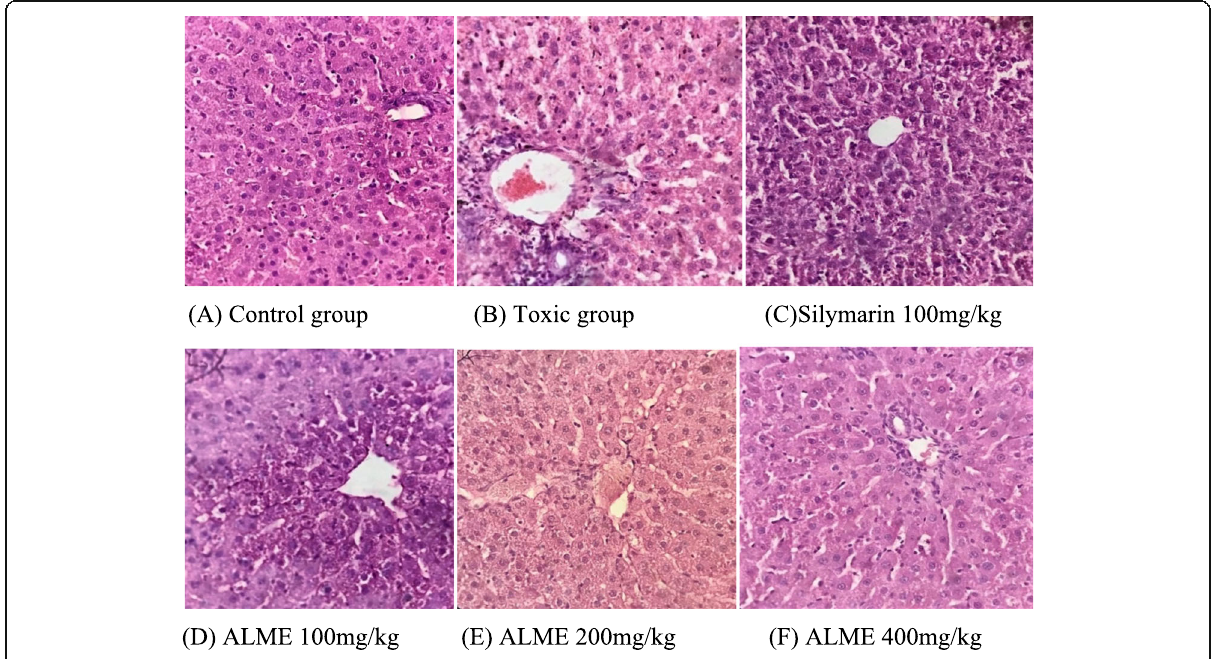
Fig. 1 Histopathological changes in hepatic tissue of rats. Done by Digital Motic Microscope Magnification 100X. a A control liver with normal architecture. b Rats treated with cadmium alone, with focal necrosis, vacuolated cytoplasm, centrilobular necrosis, sinusoidal dilatations, hepatocytic vacuolation and inflammatory cell infiltration of hepatocytes. c And e Rats treated with Standard and ALME 200 mg/kg, along with cadmium exhibited normal liver architecture. d Rats treated with ALME 100 mg/kg and cadmium exhibited mild focal necrosis and minimal damage. f Rats treated with ALME 400 mg/kg and cadmium maintained the hepatic architecture, more or less like